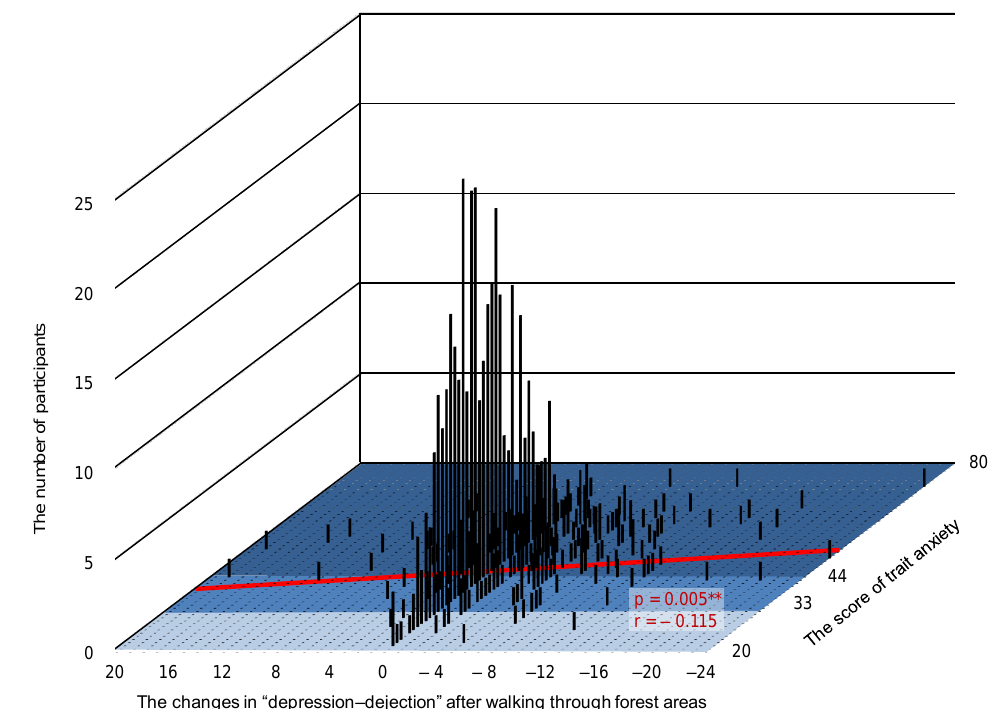
Figure 4. Three-dimensional graph showing the changes in “depression–dejection” after walking through forest areas, trait anxiety scores, and number of participants. N = 585, **: p < 0.01 by Pearson’s correlation test.